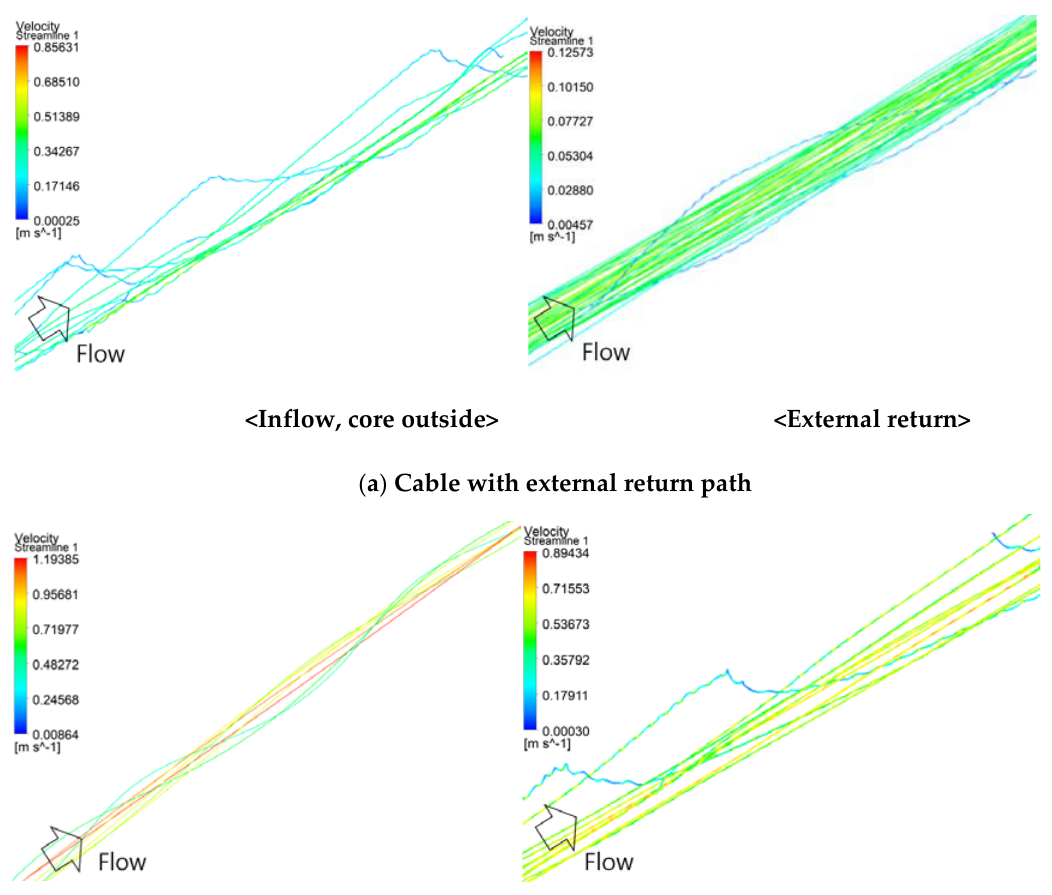
Figure 6. Streamlines in the computational fluid dynamic (CFD) analysis result for the: ( a ) cable with an external return path; ( b ) cable with internal return path at 0.57 kg/s.